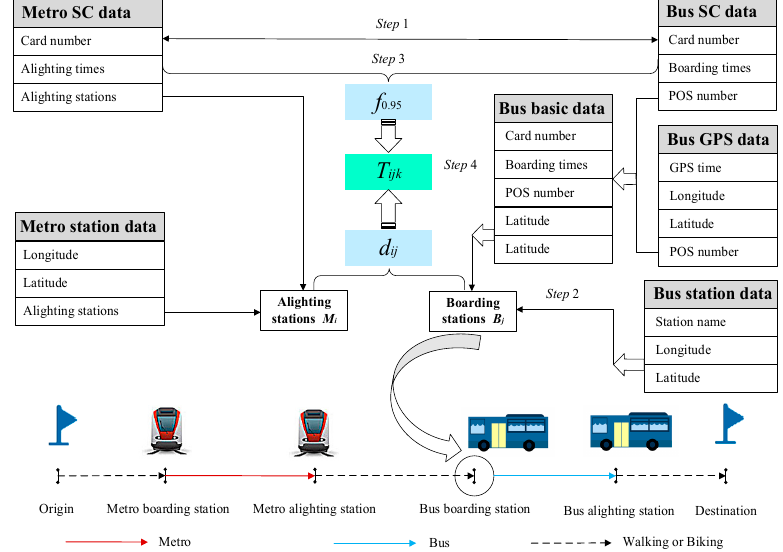
Figure 3. Identification framework based on smart card (SC) data and global positioning system (GPS) data.